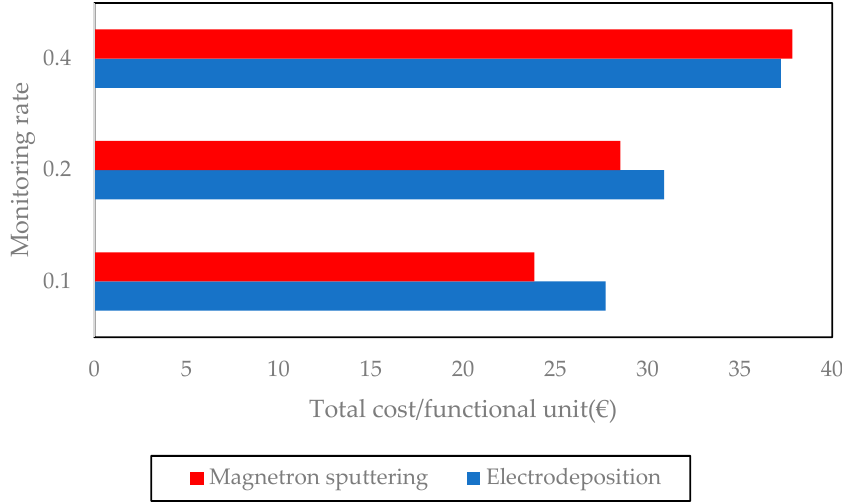
Figure 11. Total cost per functional unit with varying monitoring rate.